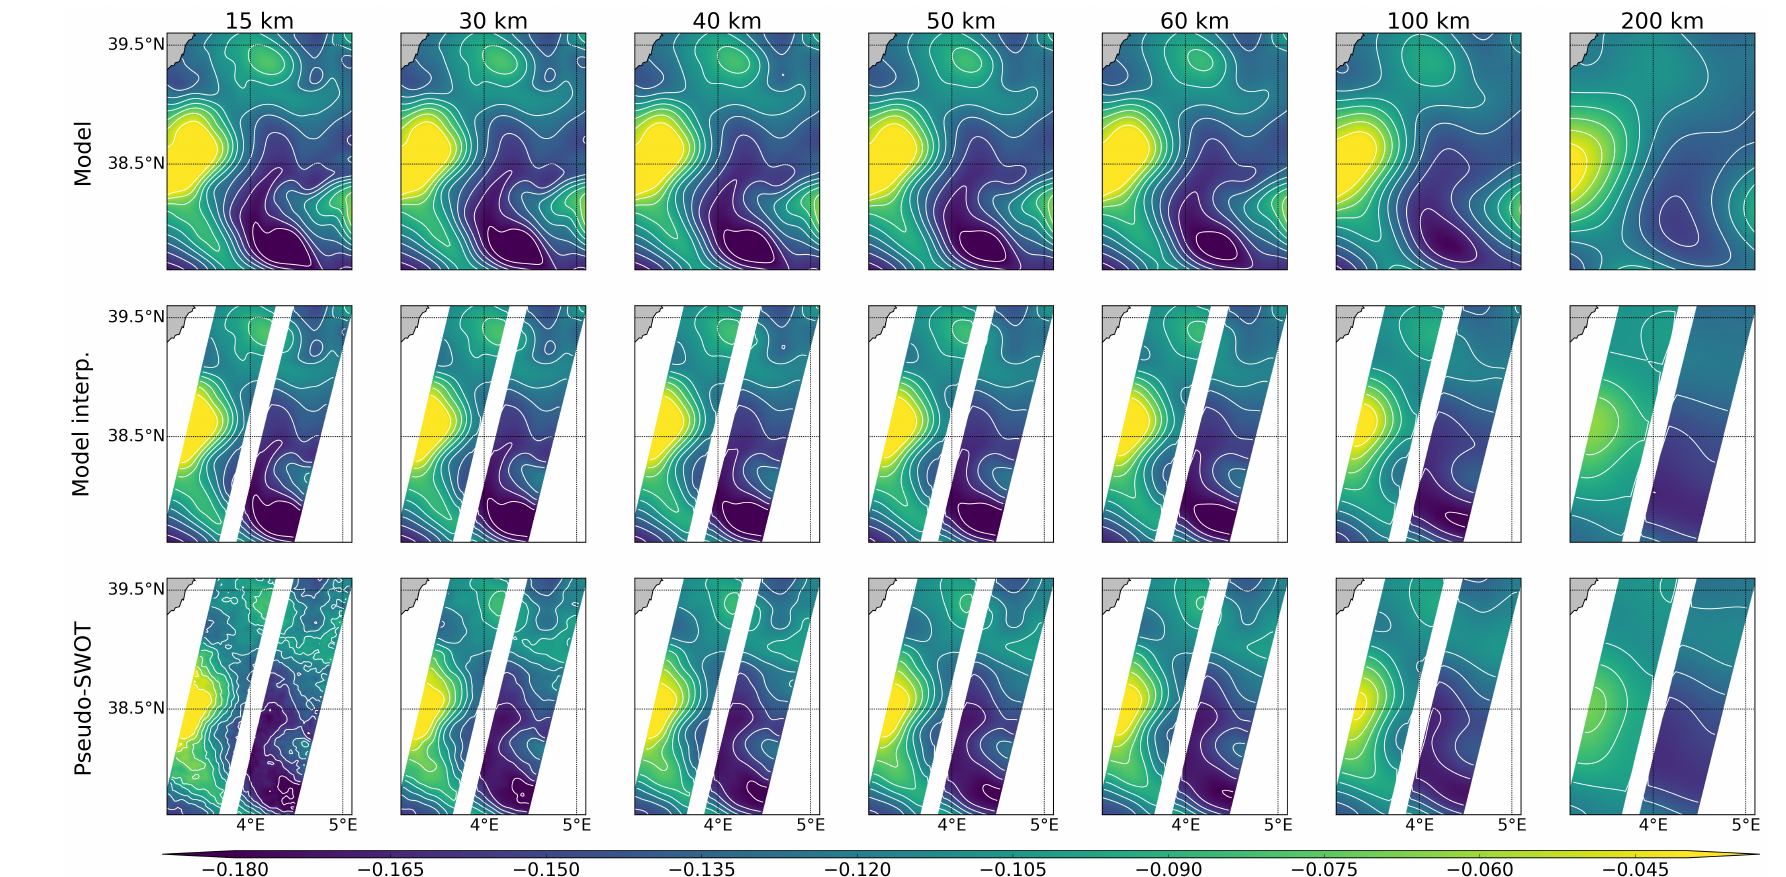
Figure 8. SSH (m) on 3 February 2009 corresponding to pass 168 of cycle